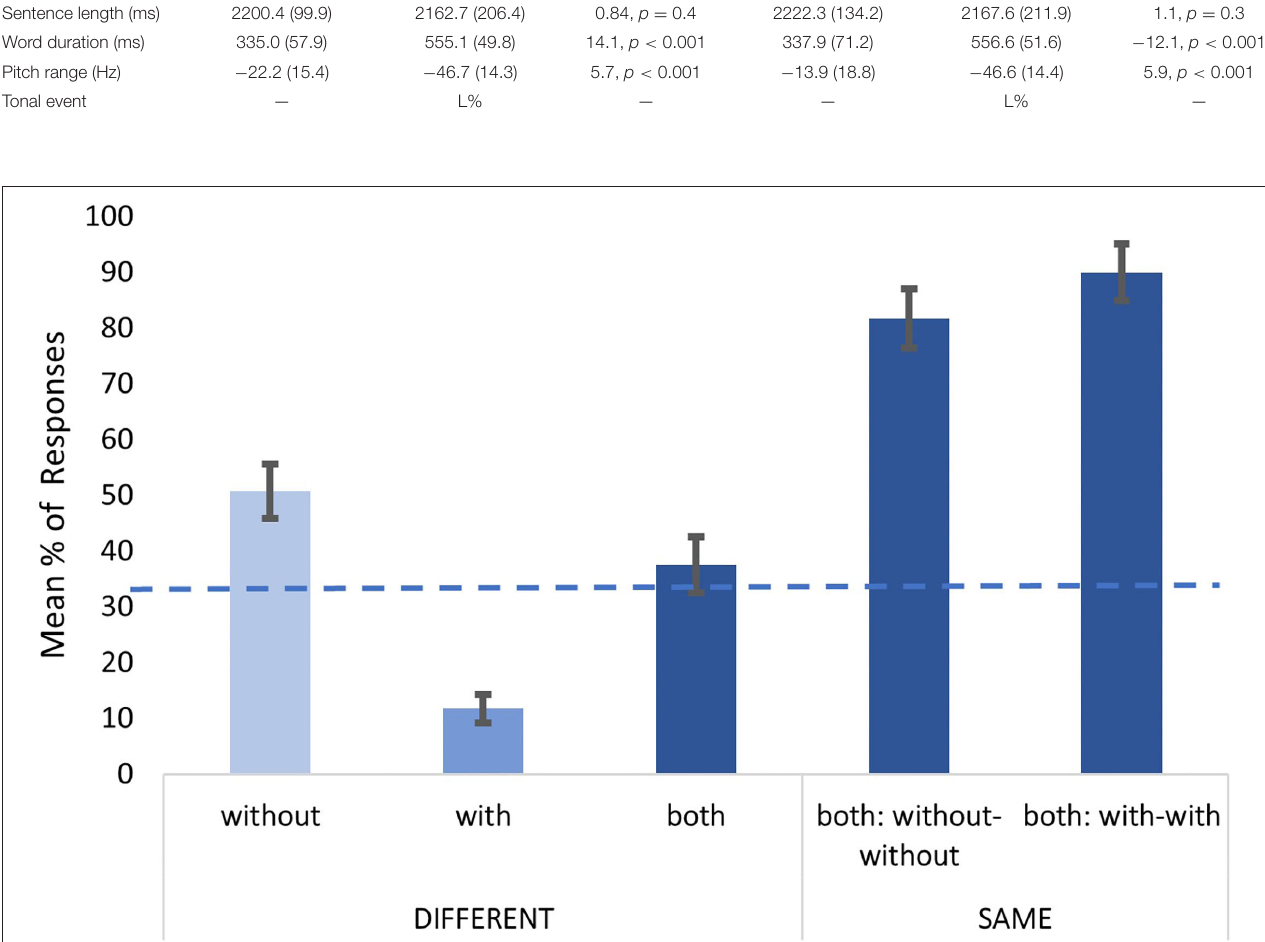
FIGURE 1 | Responses observed in the intelligibility task, for different and same trials. Error bars represent standard error of mean ( + / − 1). The dashed line represents the chance level (33.33%).